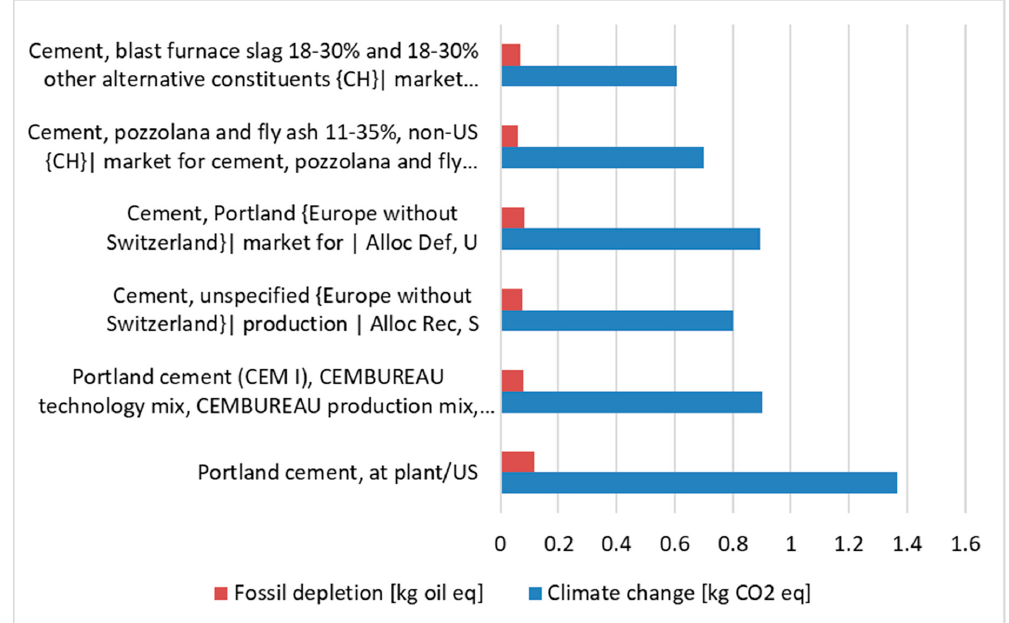
ff erent types of cement Figure 8. LCA results of different types of cement production. Figure 8. LCA results of di